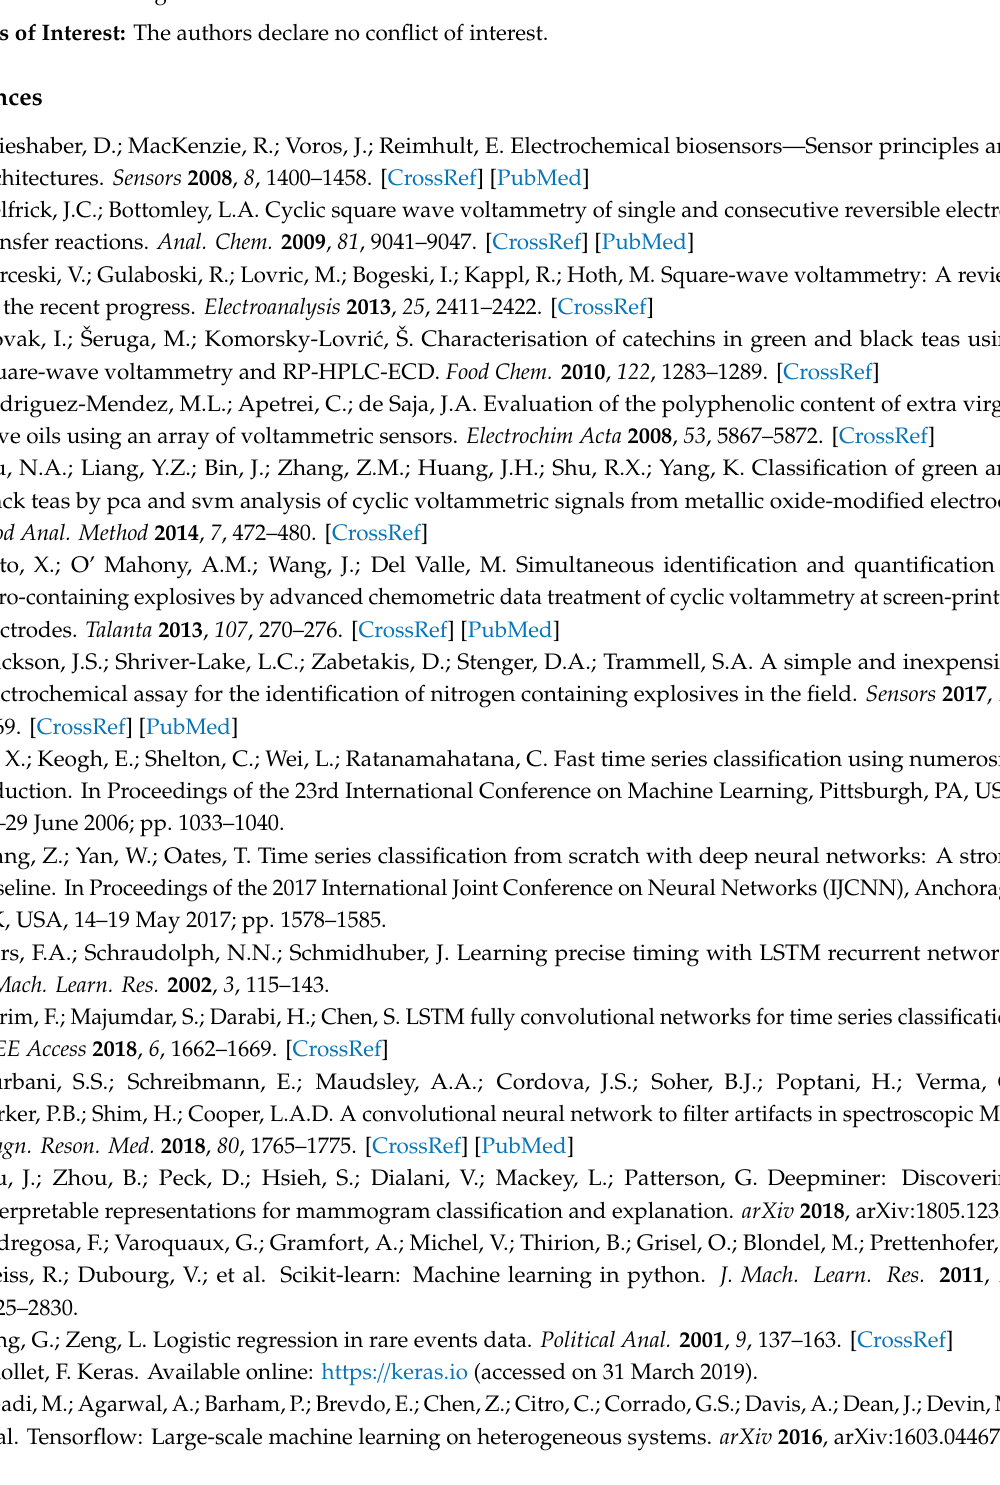
Figure S5: Representative CAMs of each class in SW-4, Figure S6: Representative CAMs of each class in SW-11, Figure S7: Representative CAMs of each class in EXP-3, Figure S8: Representative CAMs of each class in EXP-11, Figure S9.: Confusion matrix for (A) 4-SW, (B) 11-SW, and (C) 11 SW